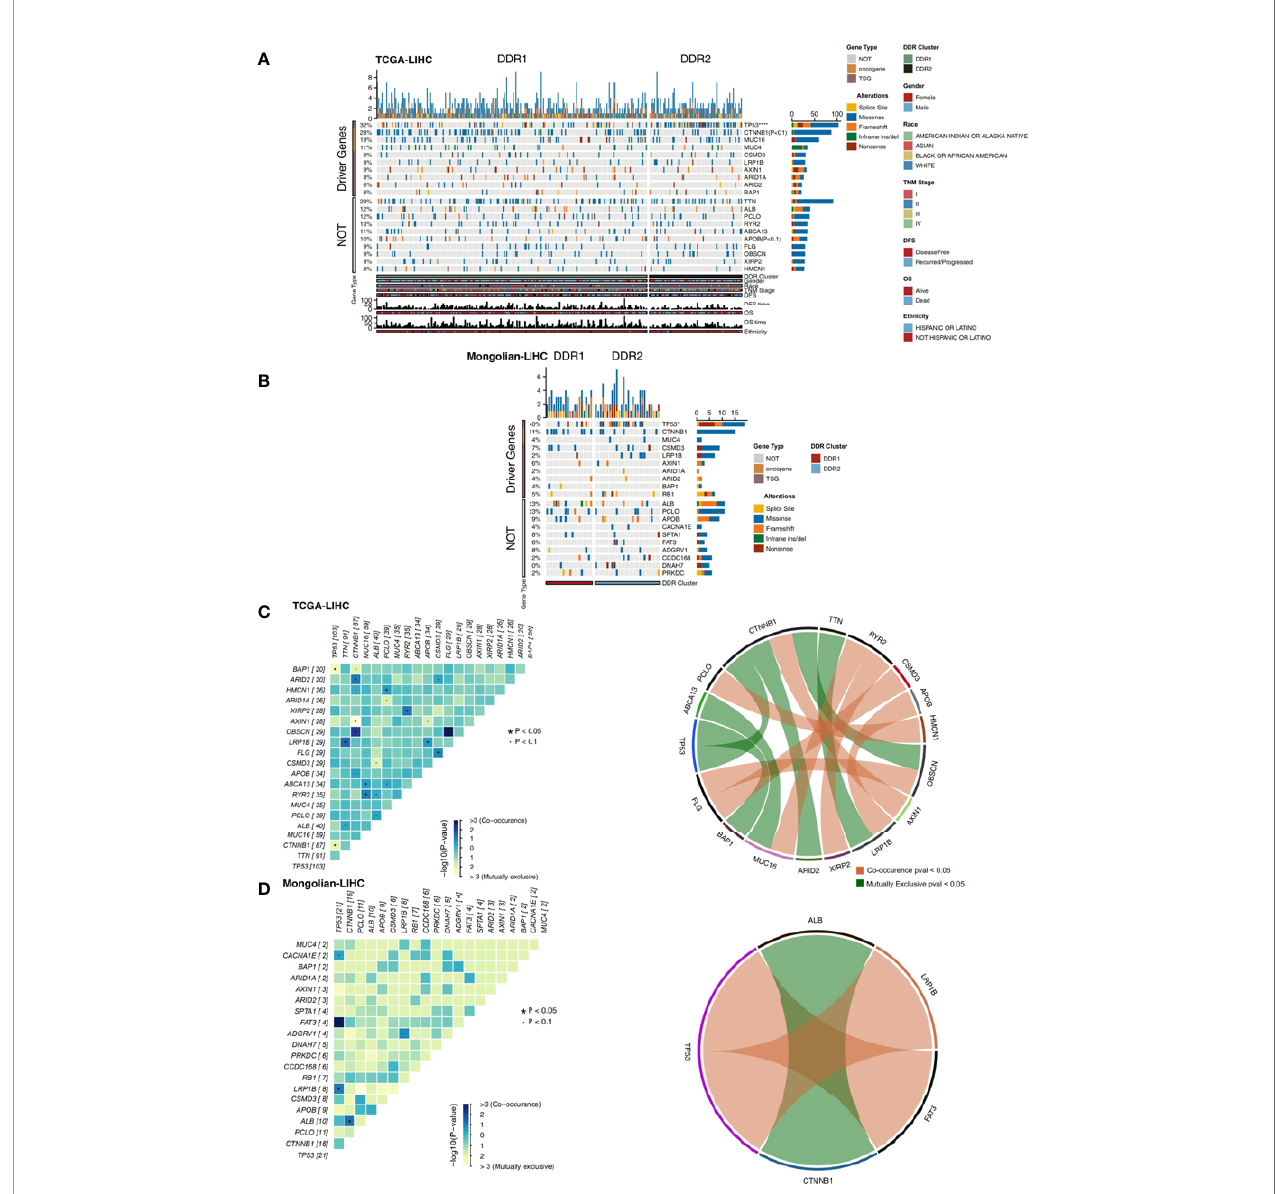
FIGURE 3 | (A) Oncoplot showing mutated driver genes (rows) across subjects (columns) split into two molecular subclasses (DDR1 and DDR2) in the TCGA-LIHC cohort. The top panel shows the genes selected as the top 10 genes with driver mutations, while the bottom panel shows the top 10 additional genes with mutations that were not driver mutations. Clinical annotations are shown at the bottom. (B) Oncoplot showing mutated driver genes (rows) across subjects (columns) split into two molecular subclasses (DDR1 and DDR2) in the Mongolian-LIHC cohort. The top panel shows the genes selected as the top 10 genes with driver mutations, while the bottom panel shows the top 10 additional genes with mutations that were not driver mutations. Clinical annotations are shown at the bottom. (C) Heatmap showing mutually exclusive and cooccurring mutations in the genes from (A) in the TCGA-LIHC cohort. Ribbon plot showing cooccurrence or mutually exclusive relationships between pairs of genes from (A) in the TCGA-LIHC cohort. (D) Heatmap showing mutually exclusive and cooccurring mutations in the genes from (B) in the Mongolian-LIHC cohort. Ribbon plot showing cooccurrence or mutually exclusive relationships between pairs of genes from (A) in the Mongolian- LIHC